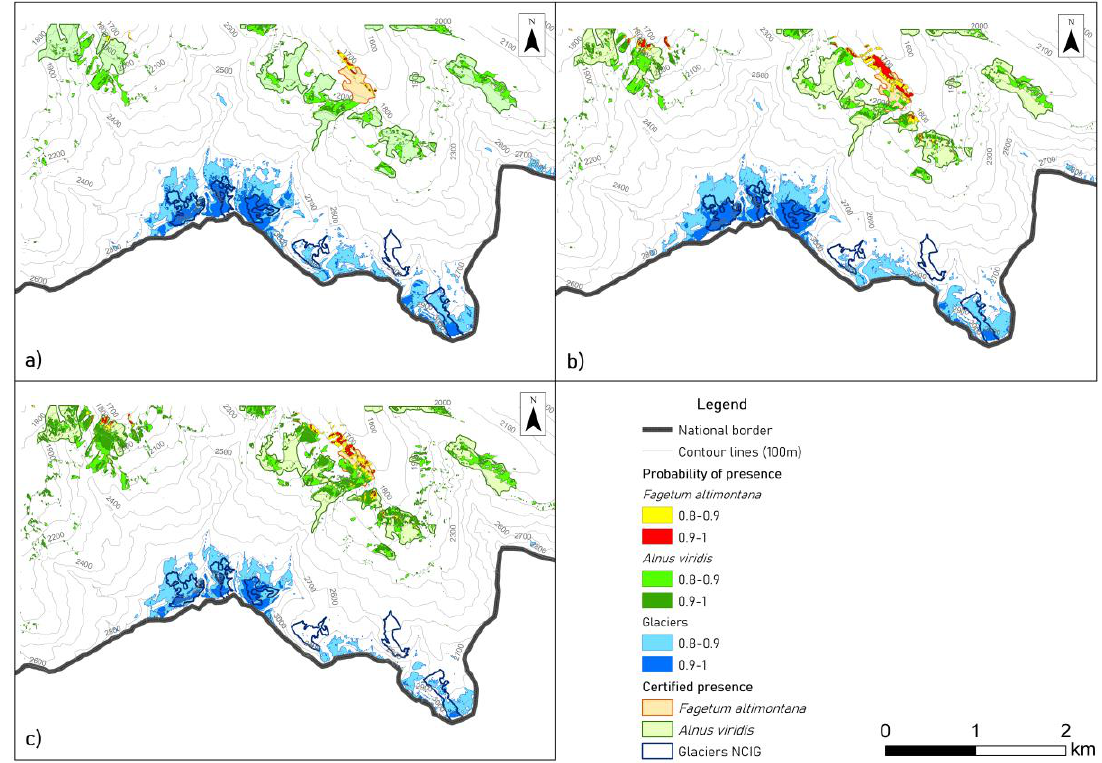
Figure 3. Maps of the three scenarios carried out from MaxEnt application of glacier, Alnus viridis and altimontane beech forest distribution ( Fagetum altimontana ). ( a ) Past scenario (1980), ( b ) Present scenario (2020), ( c ) Future scenario (2050).